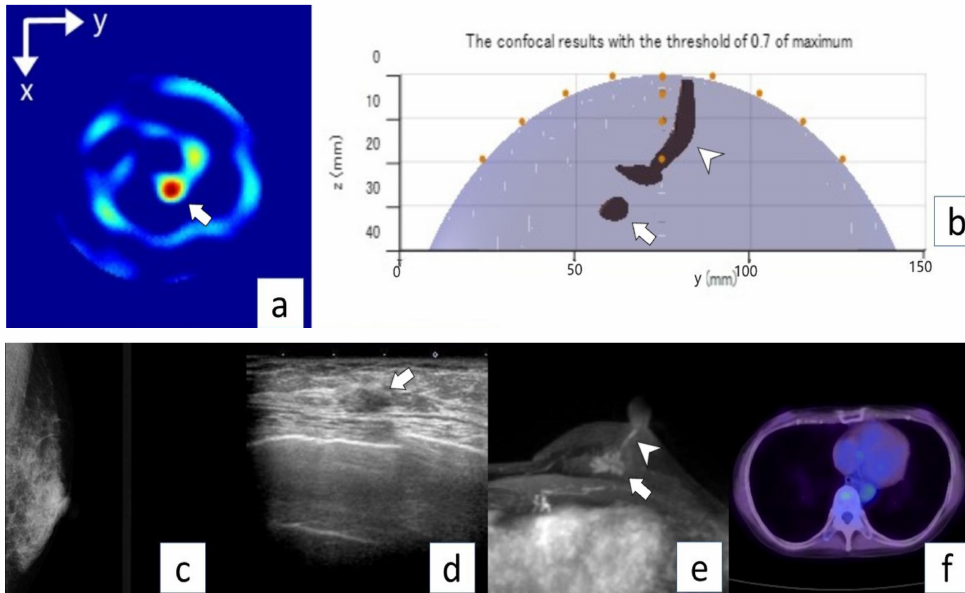
Figure 6. Representative case (Case 8). A 73-year-old woman with invasive ductal carcinoma (invasive lesion, 0.6 mm; total lesion, 60 mm) in the left breast. No abnormal lesion is seen on MG mediolateral oblique view ( a ). US shows an irregular mass in the left breast (arrow) ( b ). MRI ( c ) shows an irregular mass (arrow) and intraductal lesion extending toward the nipple (arrowhead). No abnormal lesion is seen on PET/CT ( d ). Microwave imaging 2D-coronal view ( e ) and 3D-axial view ( f ) also show breast cancer